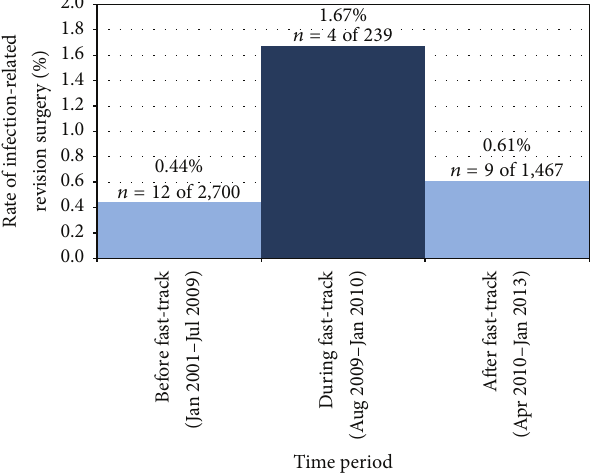
Figure 1: Rates of revision surgery due to deep infection following primary THA based on continuous quality surveillance data. The 6-month period during which the full fast-track protocol was implemented had a significantly higher rate of revision surgery due to deep infection within 3 months of the primary THA surgery. Infection-related revision surgery rates during the periods before and after the fast-track protocol was implemented were not signifi- cantly different. Surgeries including only partial implementation of thefast-trackprocedures(performedJantoApr2010)wereexcluded from the